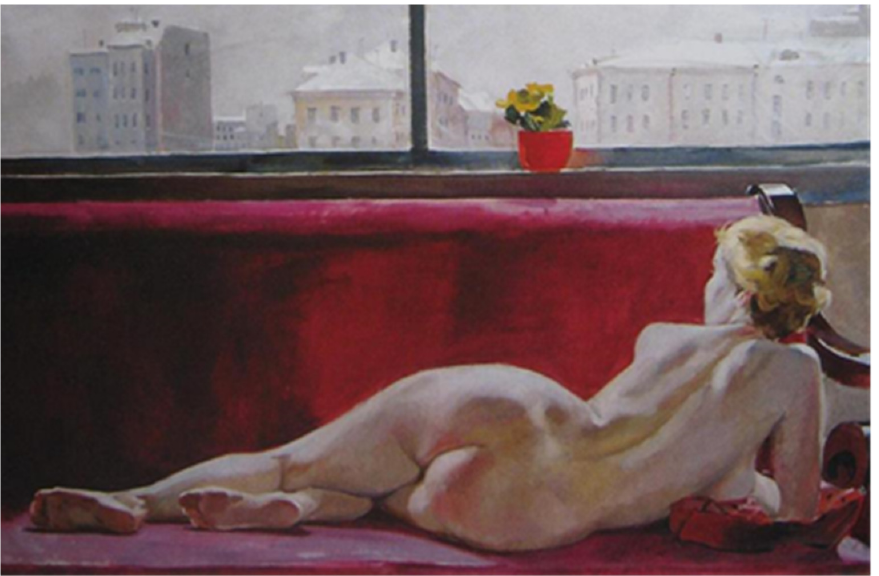
Figure 5. Aleksandr Deineka. “The Model” (1936).